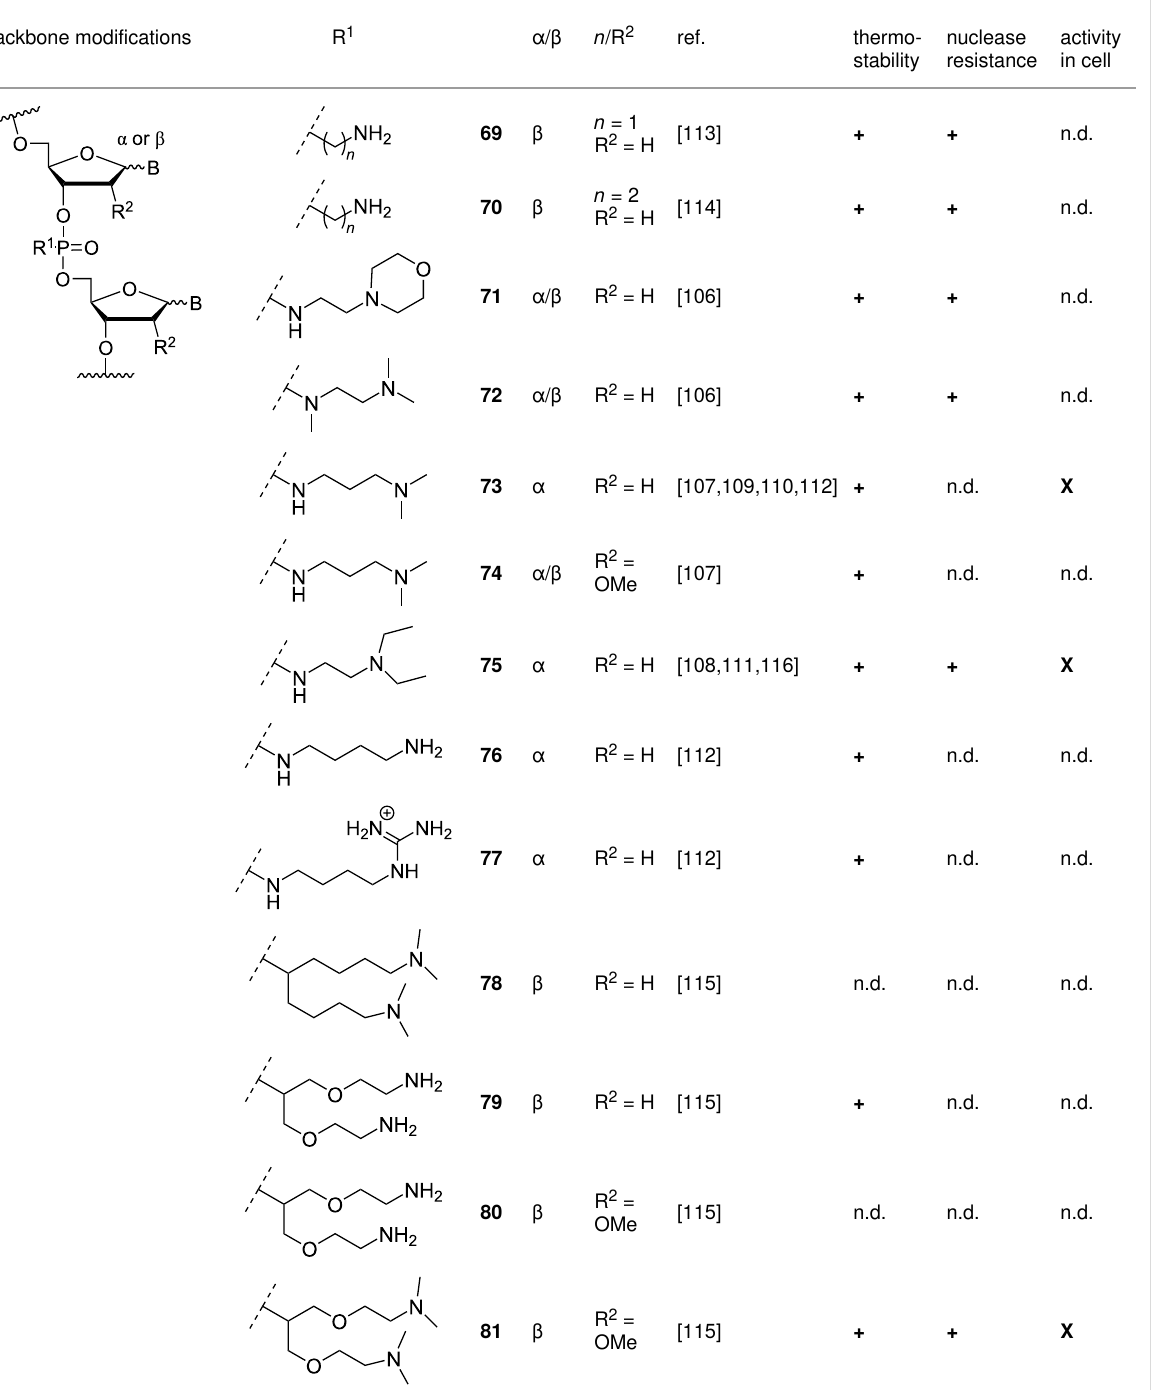
Table 8: Amine-functionalized groups as internucleoside linkage.